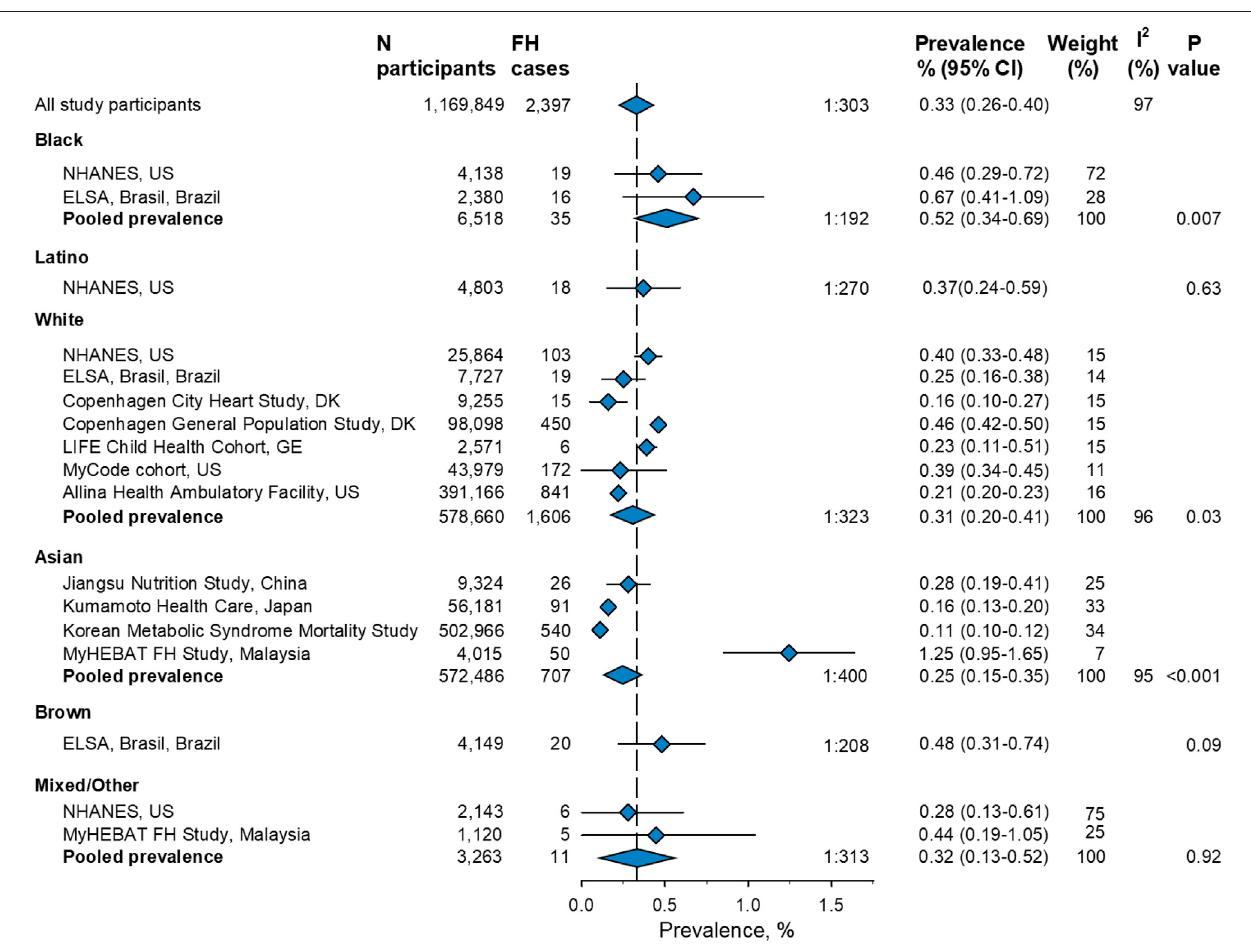
FIGURE 3 | Prevalence of familial hypercholesterolemia among ethnicities in 11 general population studies included in a meta-analysis. Small diamonds represent pointestimatesforindividualstudies.Largediamondsrepresentpooledmeta-analysisestimates.Weight(%)istheweightofthestudywithineachmeta-analysis.Testfor heterogeneity [I (Rader et al., 2003)] was signi fi cant for all meta-analyses (all p < 0.001). p -value is for comparison of the estimates for each ethnicity compared to the overall estimate (represented by the vertical broken line) of all participants. For information on ethnicity, refer to Methods. N, number, FH, familial hypercholesterolemia, CI, con fi dence